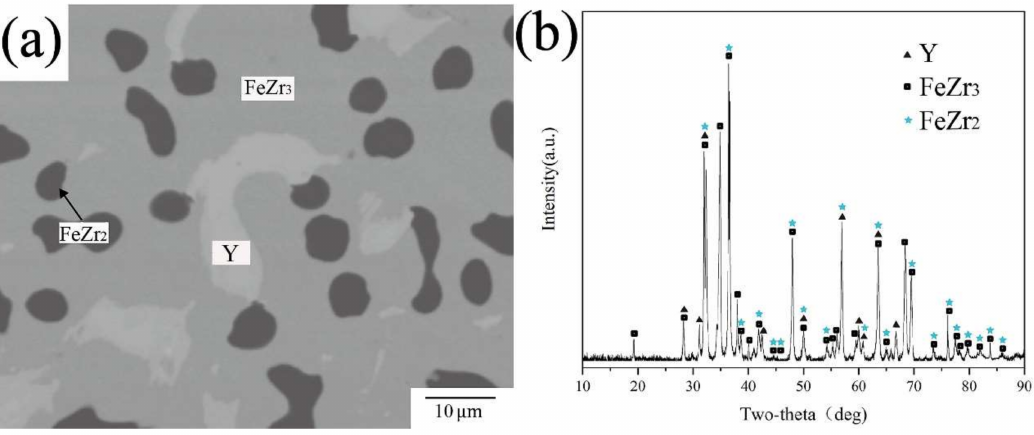
Figure 12. ( a ) BSE image of B23 ( b ) XRD pattern of